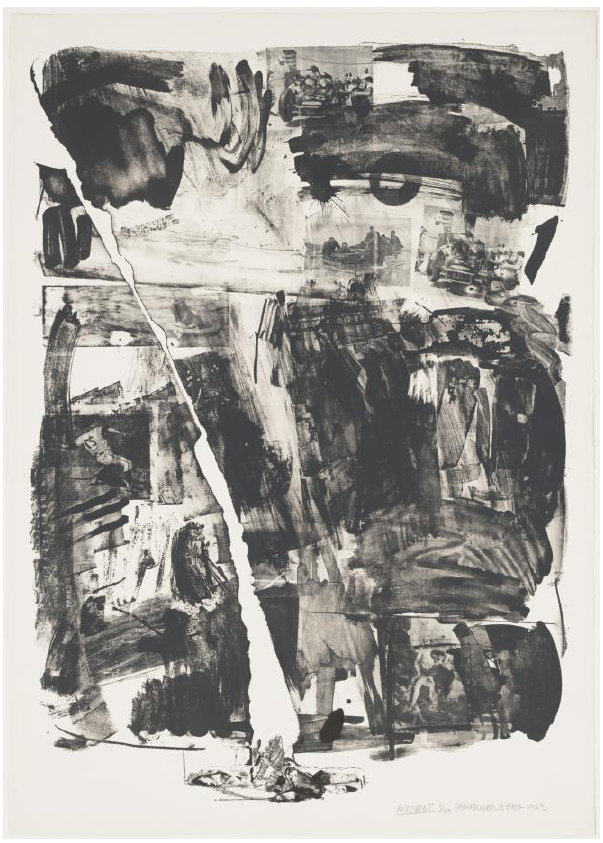
Figure 4. Robert Rauschenberg, Accident, 1963, lithograph 104.8 × 74.9 cm, from an edition of 29,